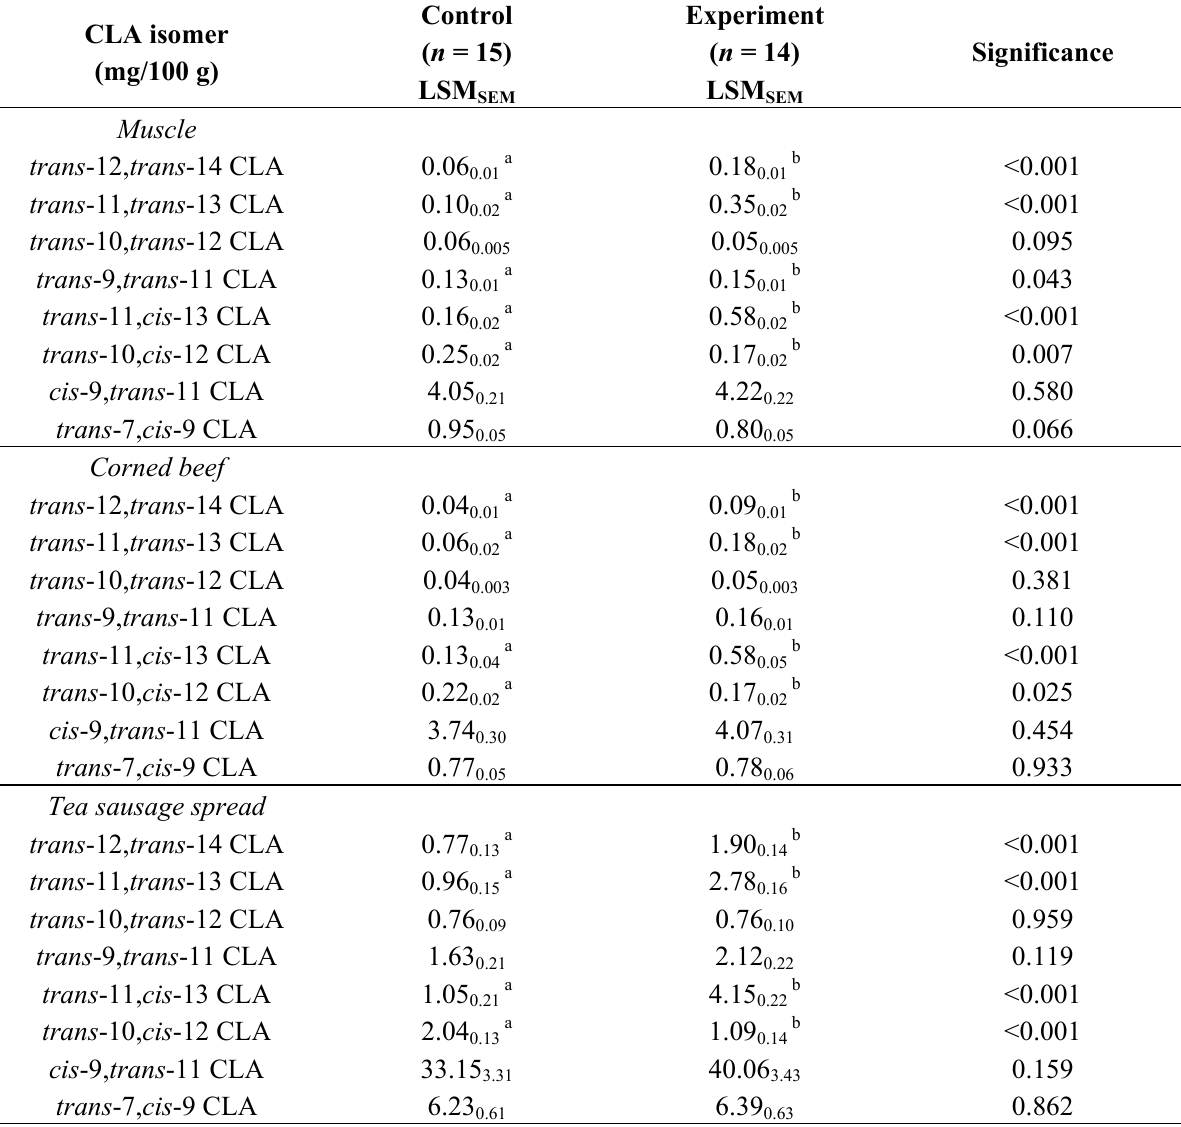
Table 5. Conjugated linoleic acid (CLA) isomer concentrations (mg/100 g) in muscle and sausages from German Holstein bulls fed different diets (different letters (a, b) denote significant effect of